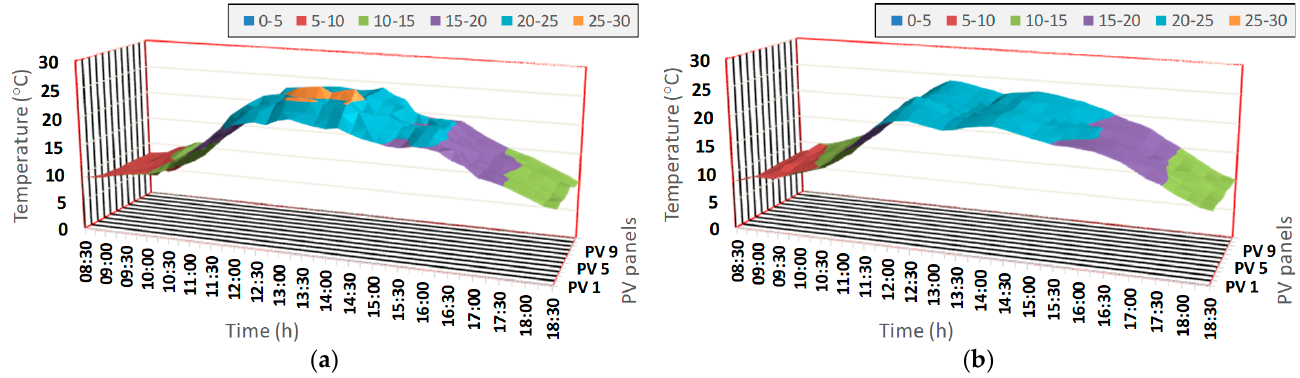
Figure 6. Temperature change in the PV panels for the bifacial CPVT systems ( a ) without HP and ( b ) with HP.